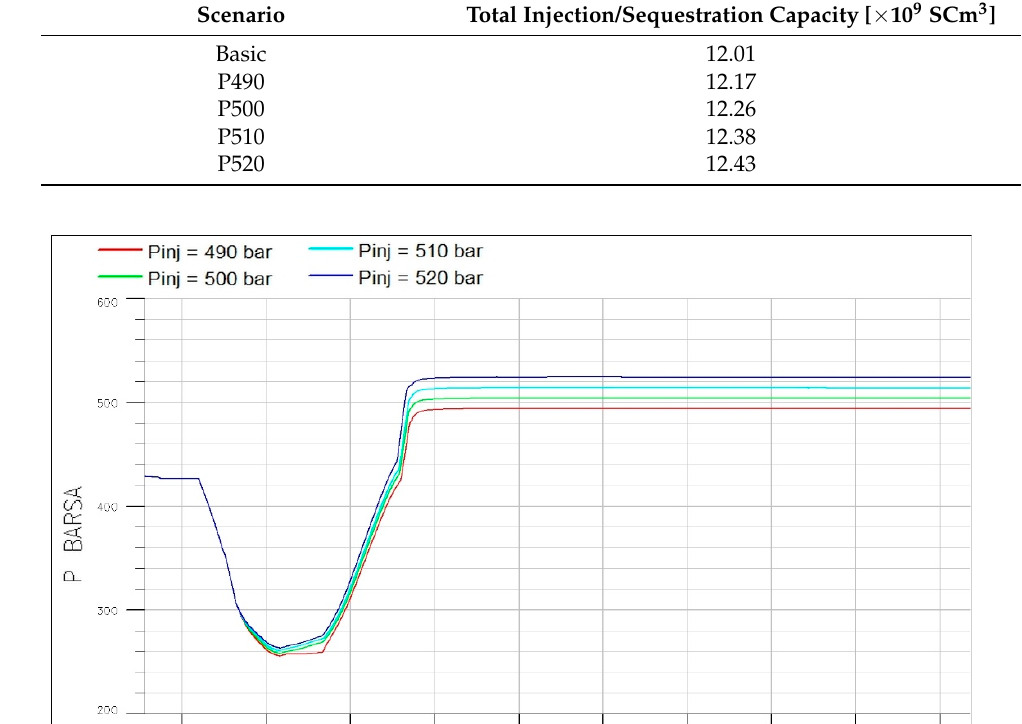
Table 8. Total CO 2 injection/sequestration capacity.